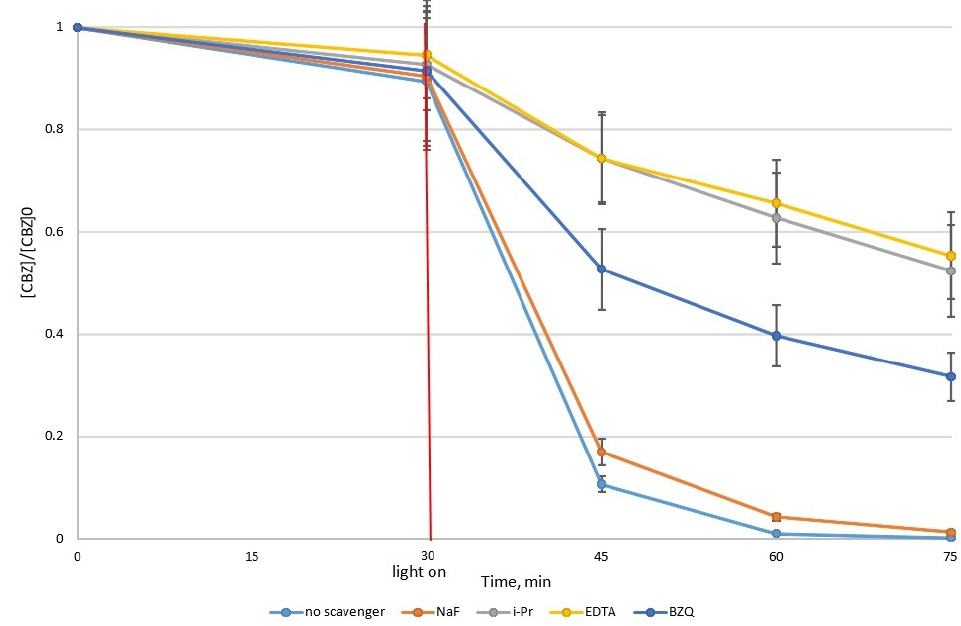
Table 3. Identified CBZ transformation